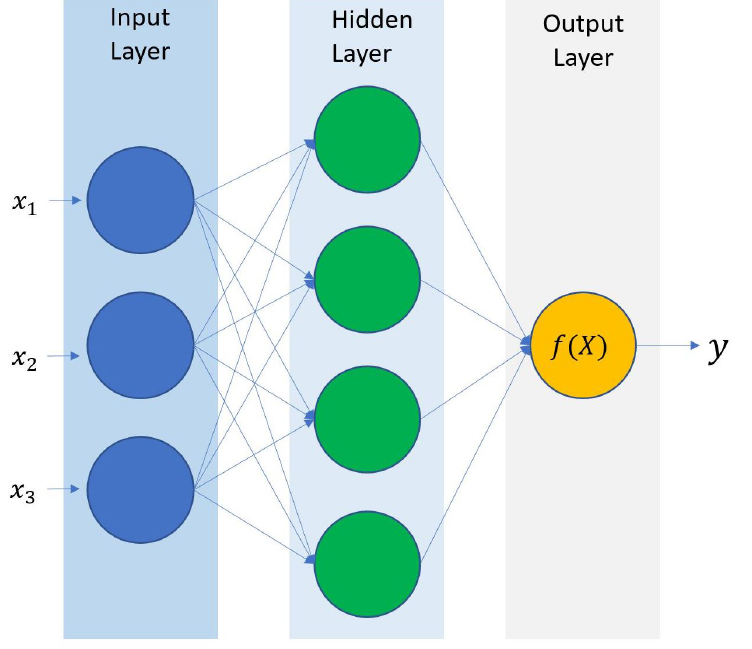
Figure 1. Artificial neural network of one single layer. Source: